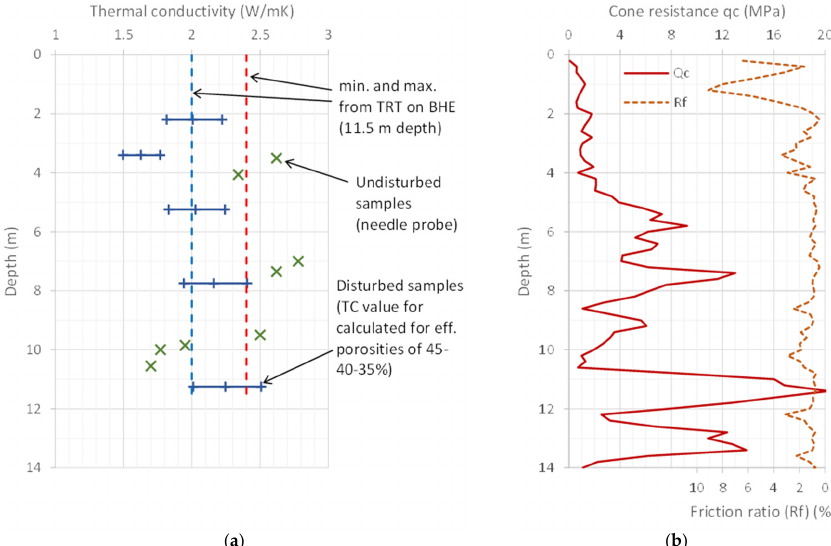
Figure 20. Soil characterisation of a site in Ostend, Belgium, showing: ( a ) thermal conductivity values from disturbed and undisturbed samples and from a TRT on a 11.5-m-deep borehole; ( b ) cone resistance and friction ratio profiles. Based on data from the Smart Geotherm project funded by the agency Flanders Innovation and Entrepreneurship.